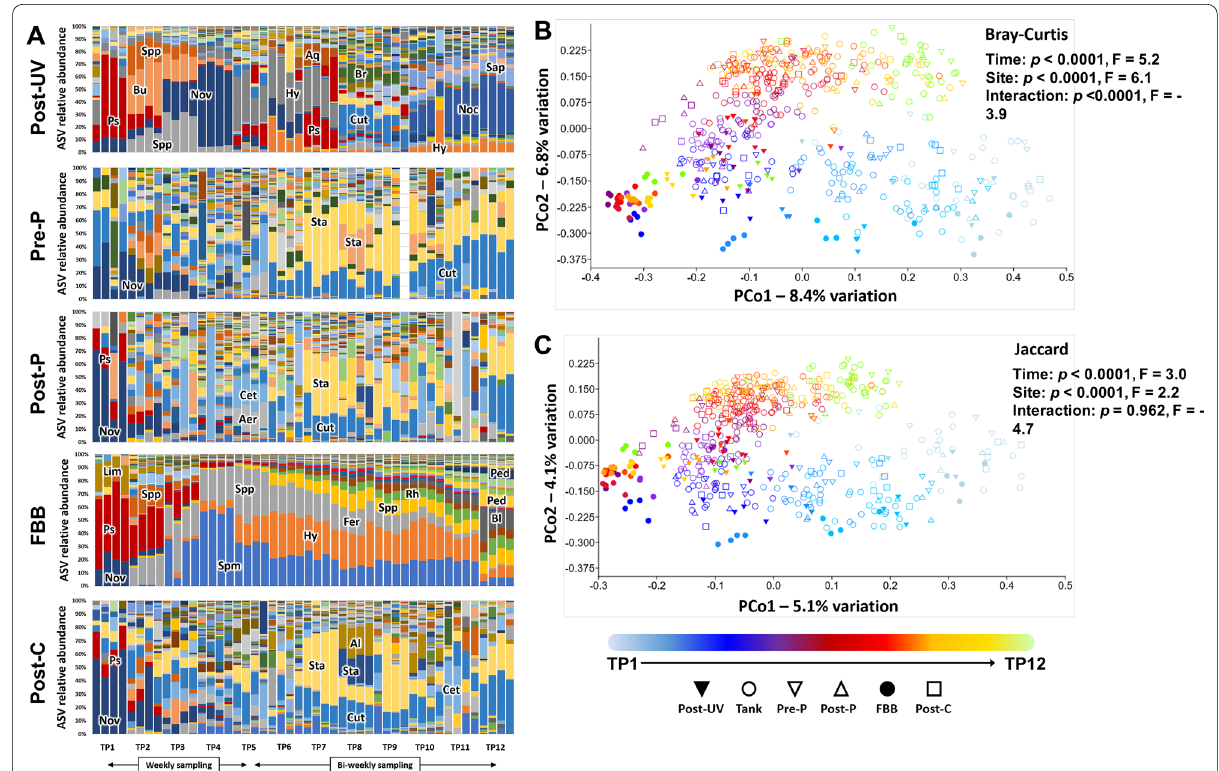
Fig. 4 Post-UV disinfection water and FBB harbor dynamic communities, distinct from other sites. Stacked bar charts showing the progression in microbiome composition in the post-UV disinfection water entering the tanks (Post-UV disinfection), the pre- and post-particulate filter water (Pre-P and Post-P, respectively), the fluidized bed biofilter (FBB), and post-carbon filter water (Post-C), sampled at 12 time-points (4 replicates/ time-point); ASV amplicon sequence variant, Aer Aeromonas , Al Alloiococcus , Aq Aquabacterium , Bl Blastocatellaceae , Br Bradyrhizobium , = = = = = = Bu Burkholderiaceae , Cet Cetobacterium , Ch Chitinophagales , Cut Cutibacterium , FBB fluidized bed biofilter, Fer Ferruginibacter , = = = = = = Hy Hydrogenophaga , Lim Limnobacter , Noc Nocardia , Nov Novosphingobium , Ped Pedosphaeraceae , Per Perlucidibaca , Pl Plesiomonas , = = = = = = = Ps Pseudomonas , Rh Rhodobacteraceae , Sap Saprospiraceae , Spp Sphingopyxis , Spm Sphingomonadaceae , Sta Staphylococcus , Vib Vibrio = = = = = = = ( A ) and principal coordinate analysis plots of those samples and tank water, based on Bray–Curtis ( B ) and Jaccard ( C ) similarities. ASV amplicon = sequence variant, TP time-point, color-bar and symbol legends at bottom; taxonomic abbreviations listed at beginning of manuscript. p and F = values associated with main effects of time and sample site based on two-way permutation multivariate analysis of variance